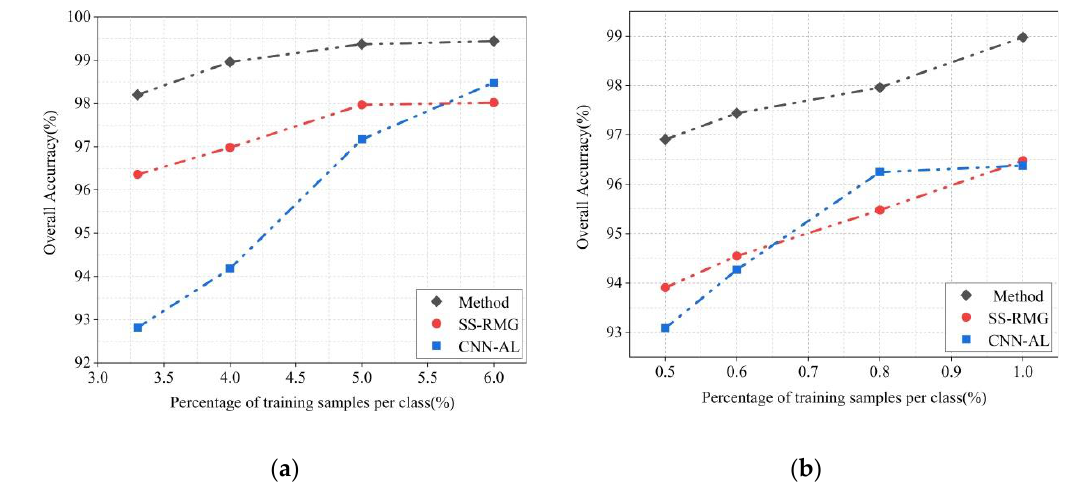
Figure 11. Curves of overall accuracies versus different percentages of training samples, obtained by different methods on two datasets: ( a ) Indian Pines dataset, ( b ) Pavia University dataset.